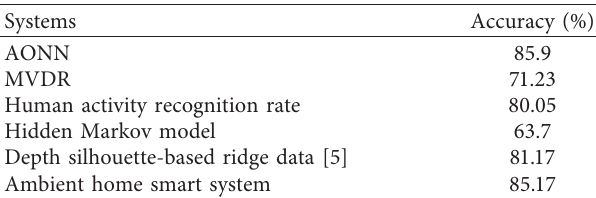
Table 2: Comparison of the proposed system with conventional systems with respect to